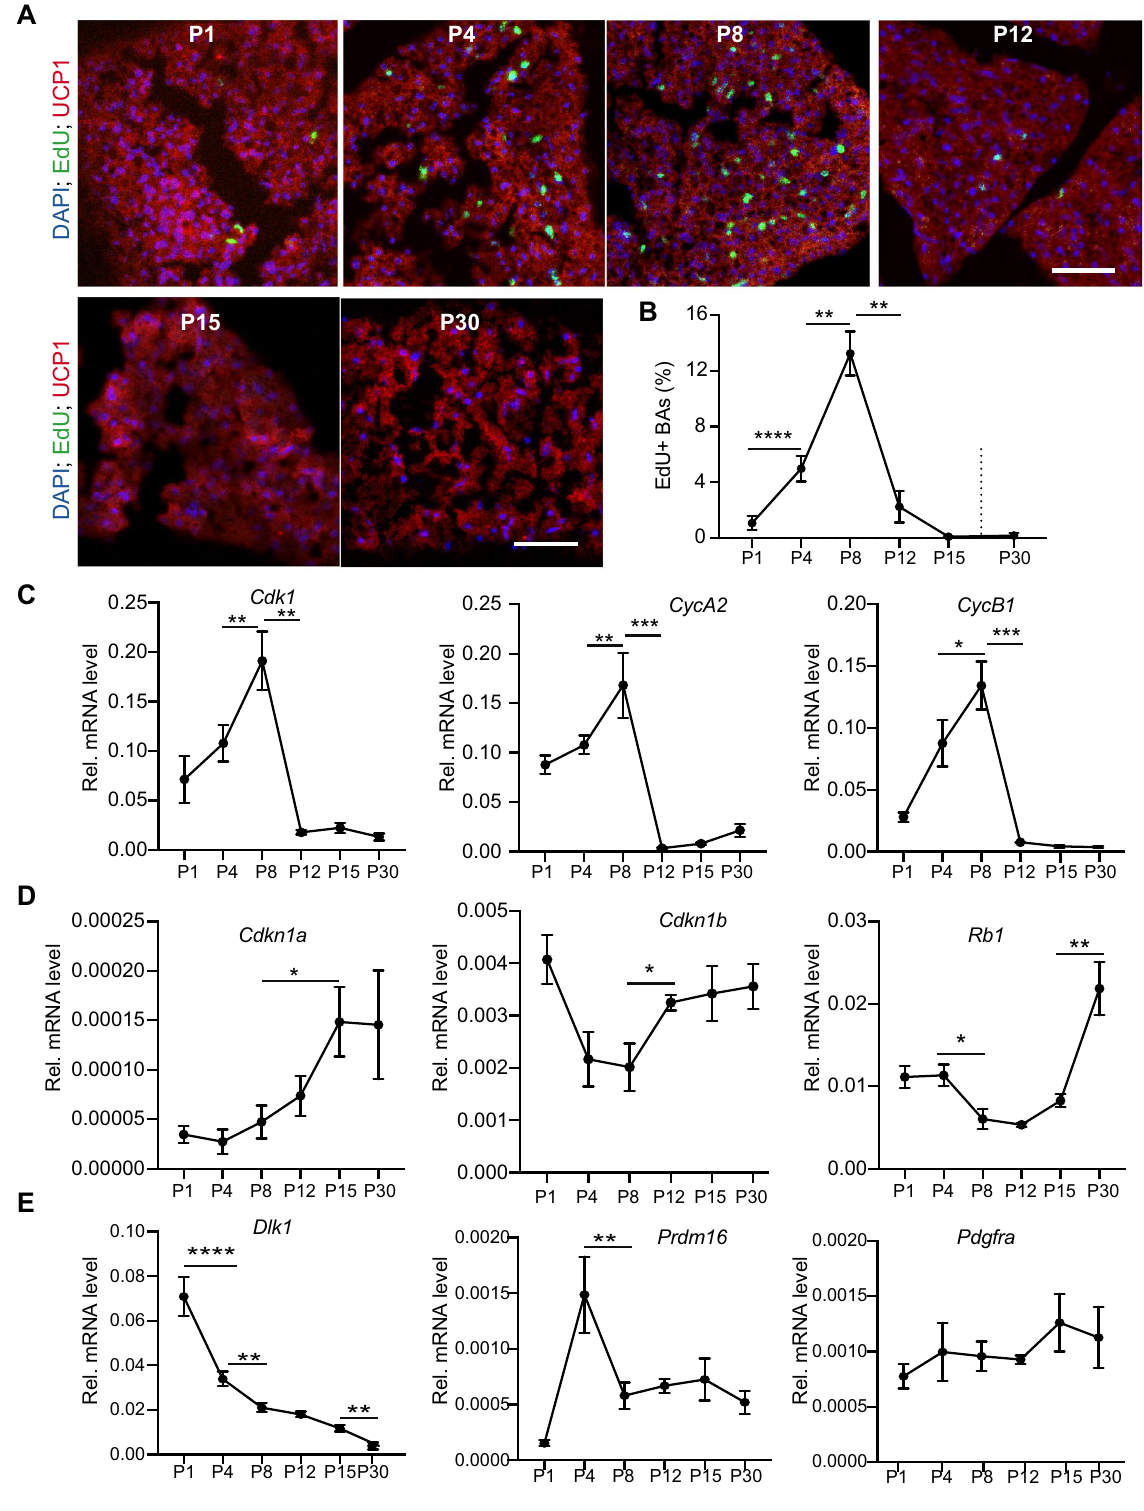
Figure 3. Analysis of BAs DNA synthesis activity. iBAT collected at indicated ages was used for analysis. ( A ) Representative immunofluorescence images of iBAT labeled with EdU. EdU was subcutaneously injected into mouse pups 24 h before iBAT collection. Bar = 50 µm. ( B ) Quantification of EdU positive BAs. N = 4 for each time points. ( C–E ) qRT-PCR measurement of gene expression at different ages. Total RNA from iBAT was used for qRT-PCR. ( B – E ) One-way ANOVA with post-hoc Tukey’s multiple comparisons test. * P < 0.05, ** P < 0.01, *** P < 0.001. N =